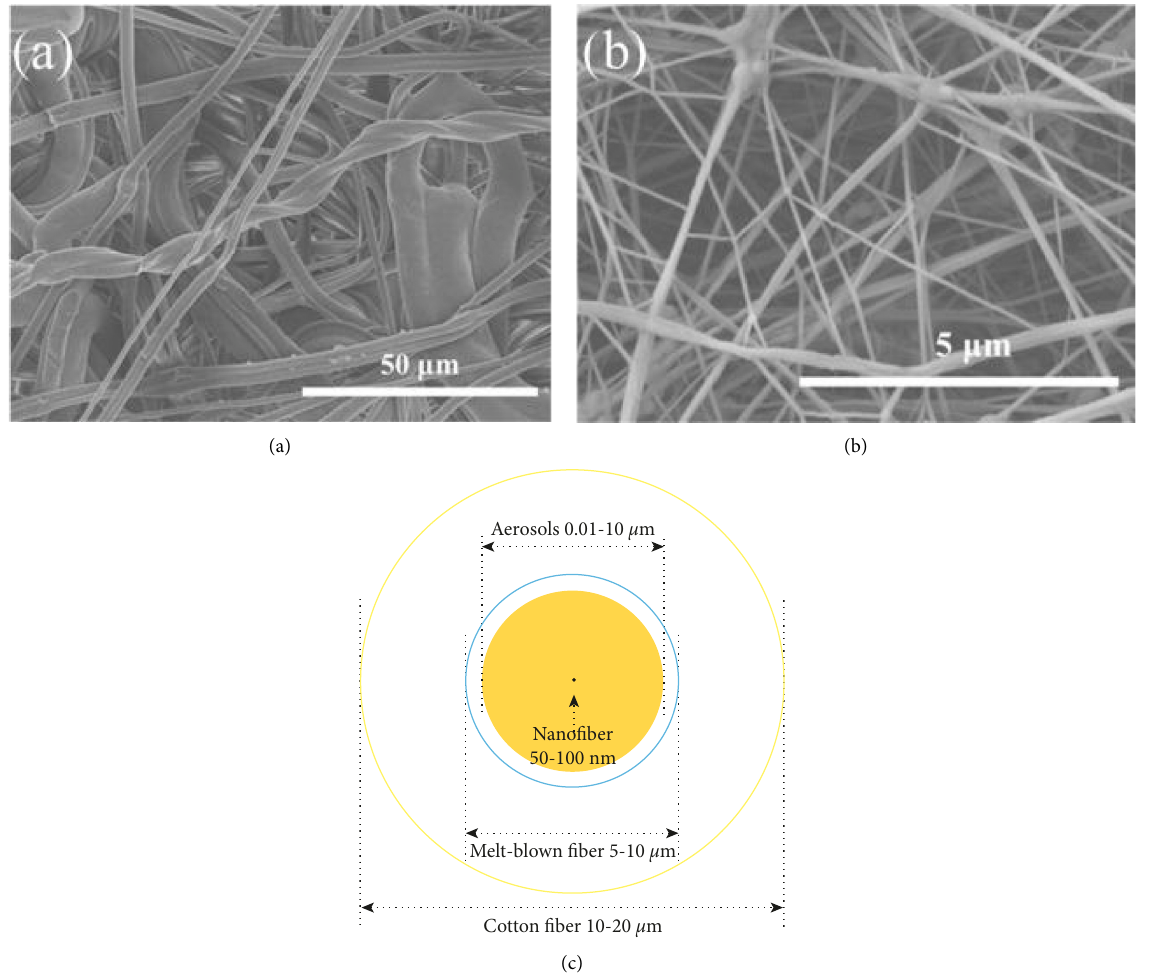
Figure 8: SEM images of (a) melt-blown fabrics, (b) nanofiber membrane, and (c) schematic for the comparison between melt-blown fiber and nanofiber diameters that are used to fabricate masks (adapted with permission from ref.